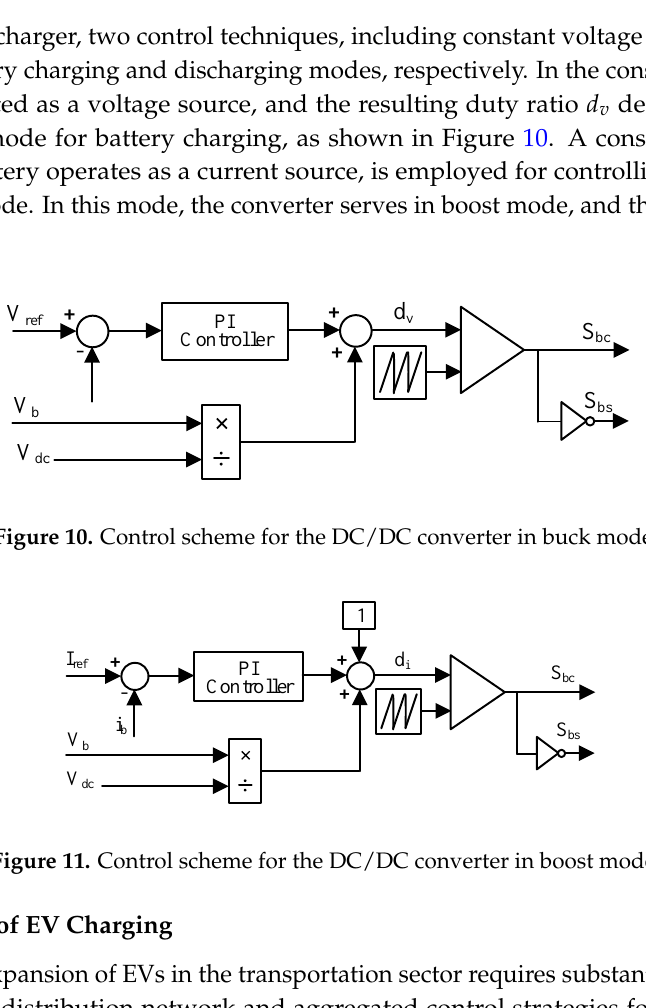
Figure 9. EV battery charger configuration.